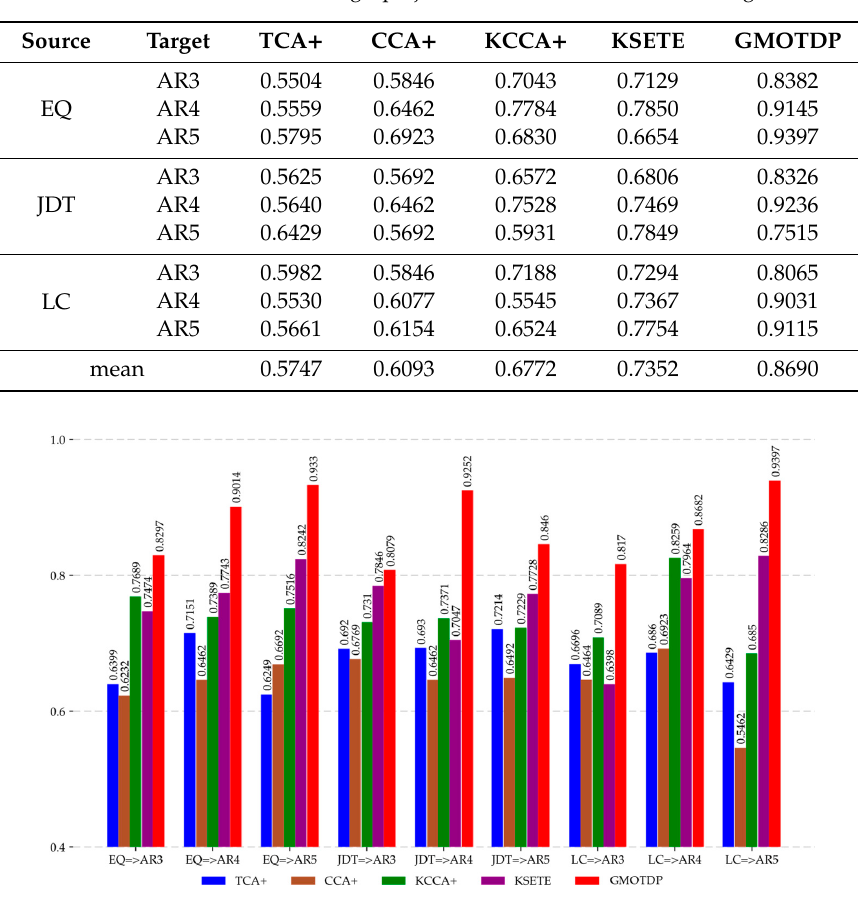
Figure 6. Results for source and target projects without common features using different methods.